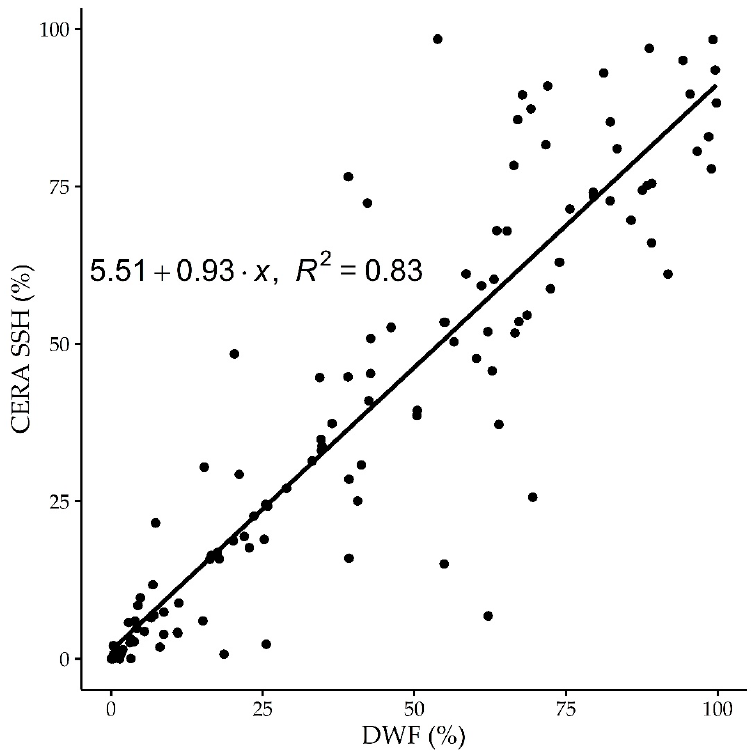
Figure 9. Linear model of DWF map and CERA SSH product.